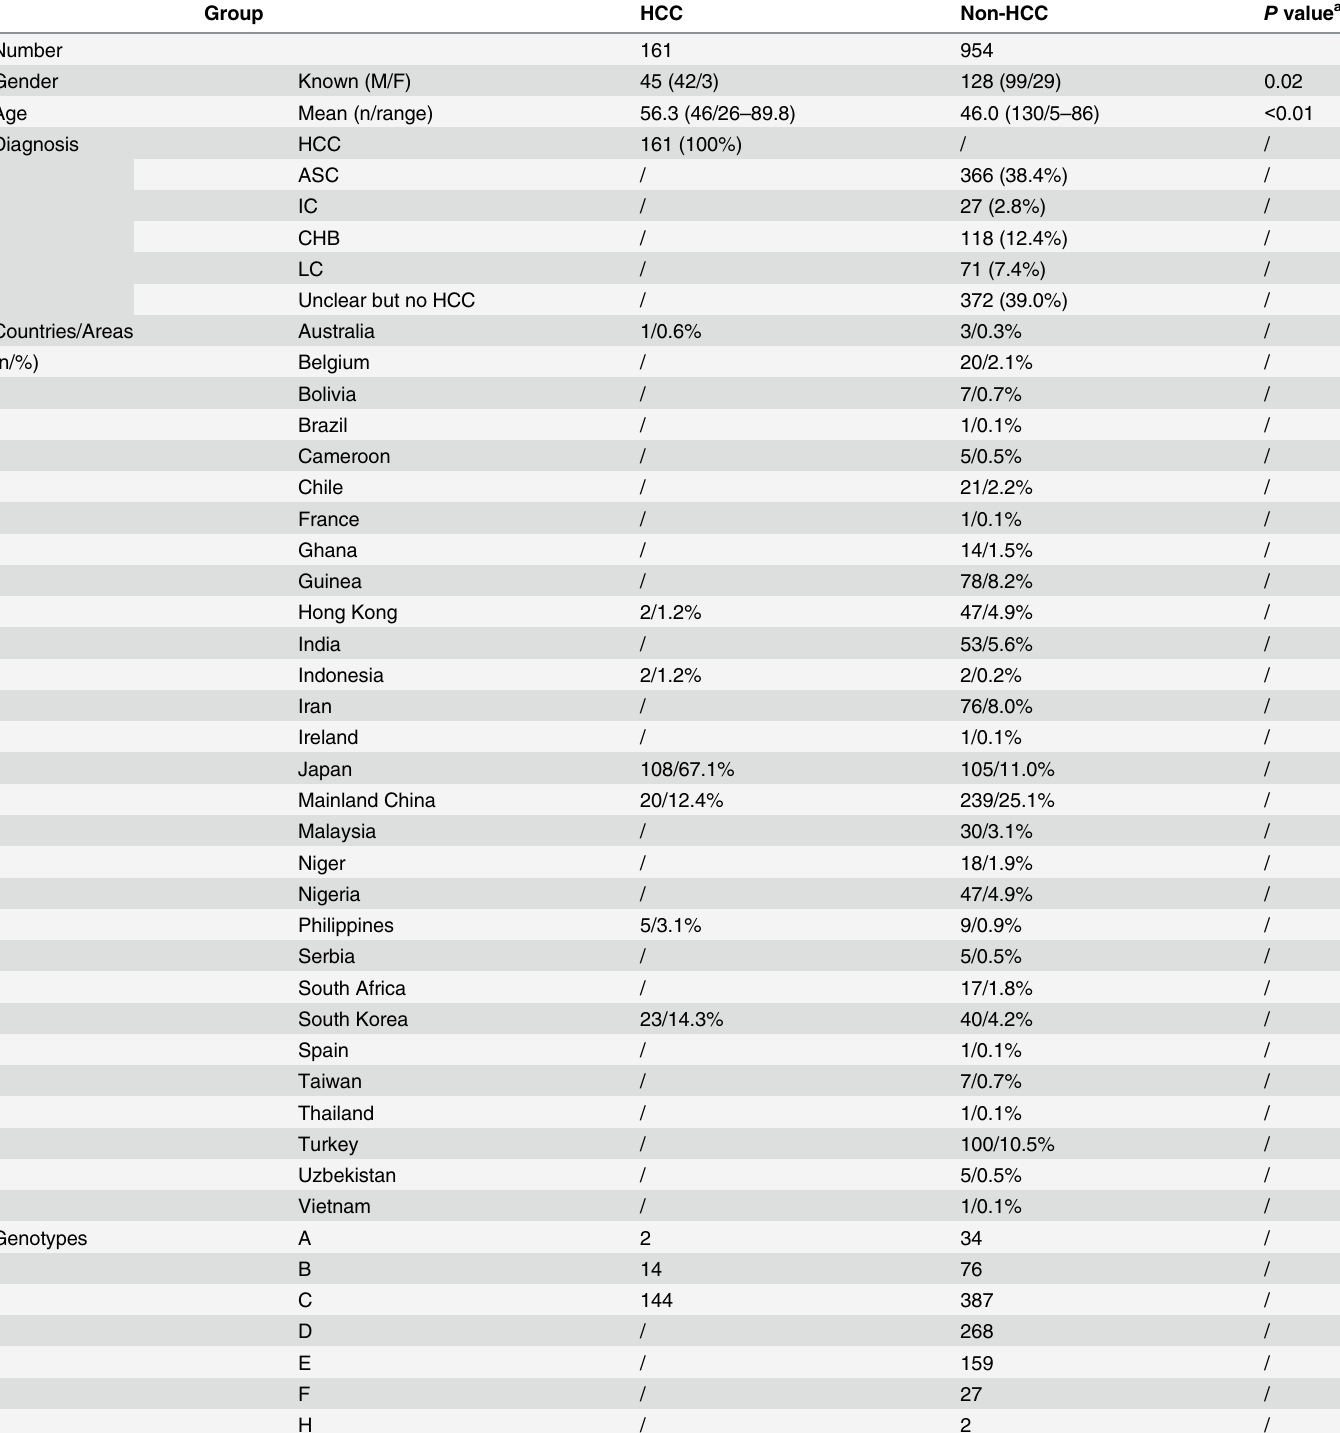
Table 1. The demographic information of enrolled